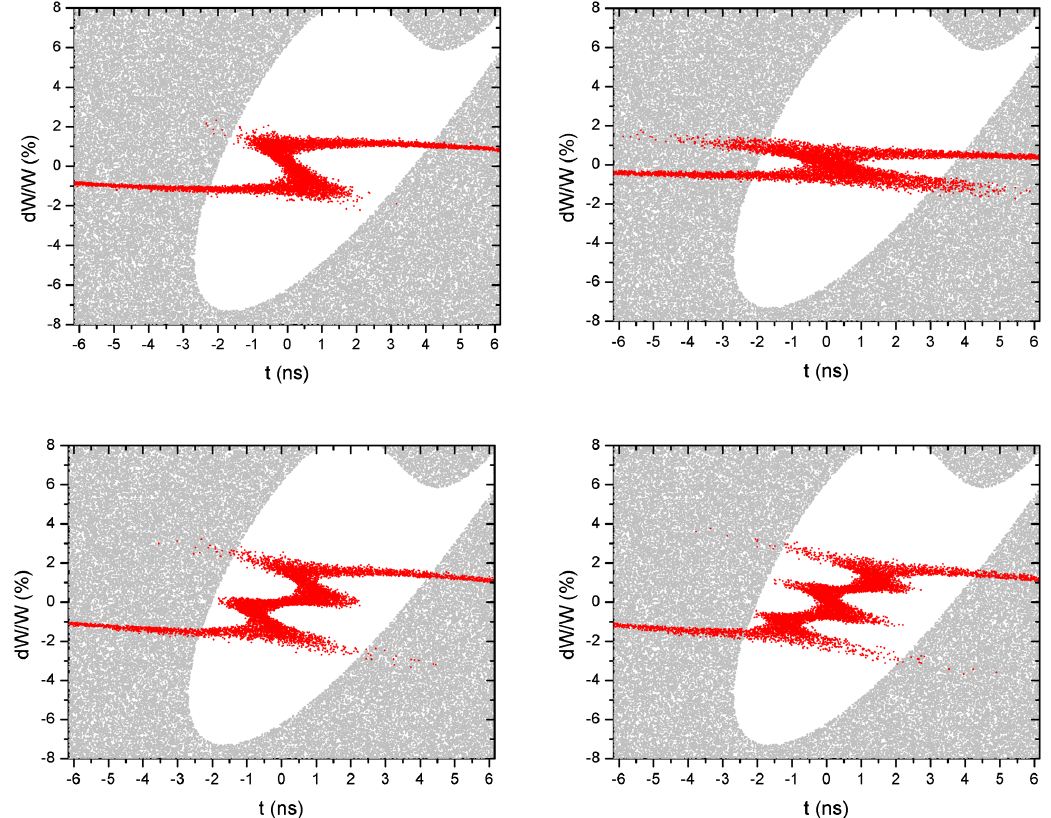
FIG. 28. Simulated particle distributions in longitudinal phase space after being bunched by the first harmonic, the second harmonic, 1 st þ 2 nd harmonics and 1 st þ 2 nd þ 3 rd harmonics, respectively.